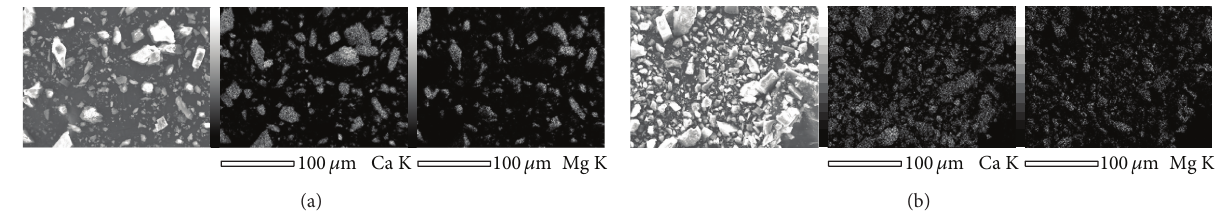
Figure 5: SEM micrographs and the energy-dispersive X-ray (EDX) analysis results of the dolomite pyrolysis products calcined in an Ar atmosphere (a) and vacuum (b).